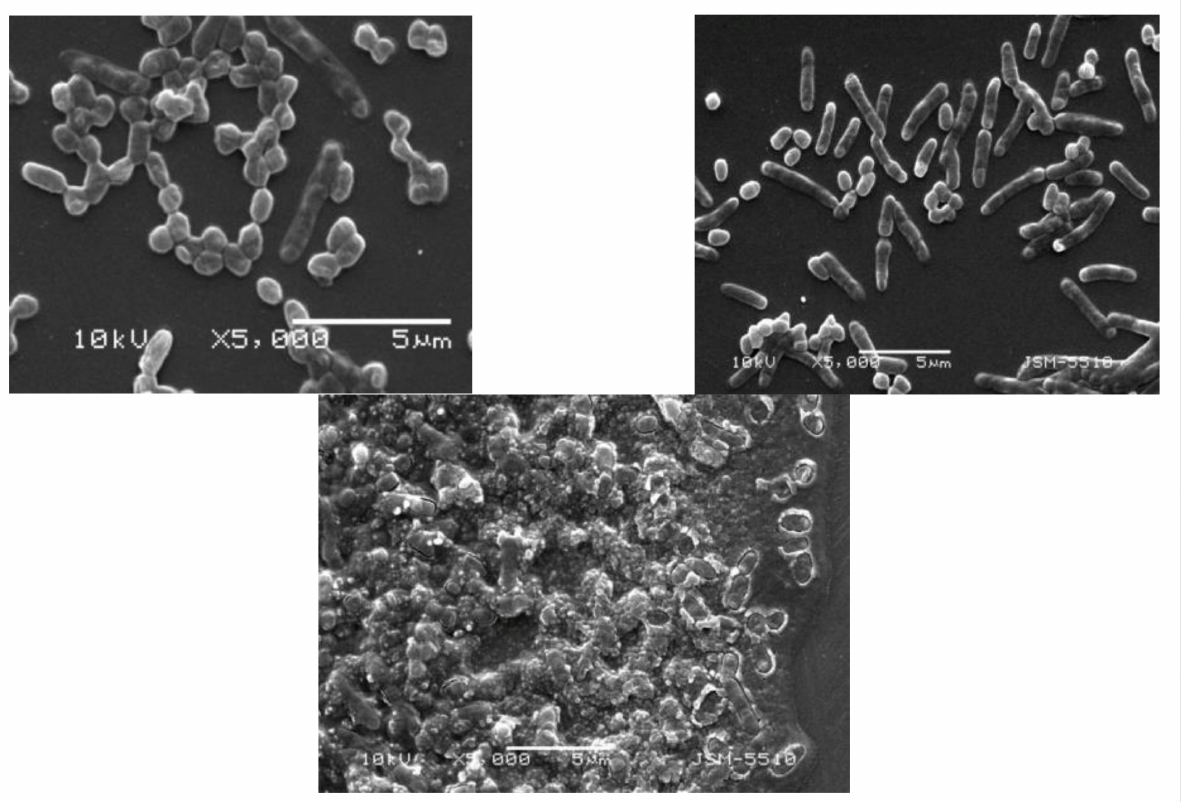
Figure 4. SEM micrographs of Brevibacillus laterosporus BT 271 ( × 5000, scanning electron microscope JEOL JSM 5510): ( top left )—control; ( top right )—plasma-treated sample with a duration of 30 s; ( below )—plasma-treated sample with a duration of 60 s.